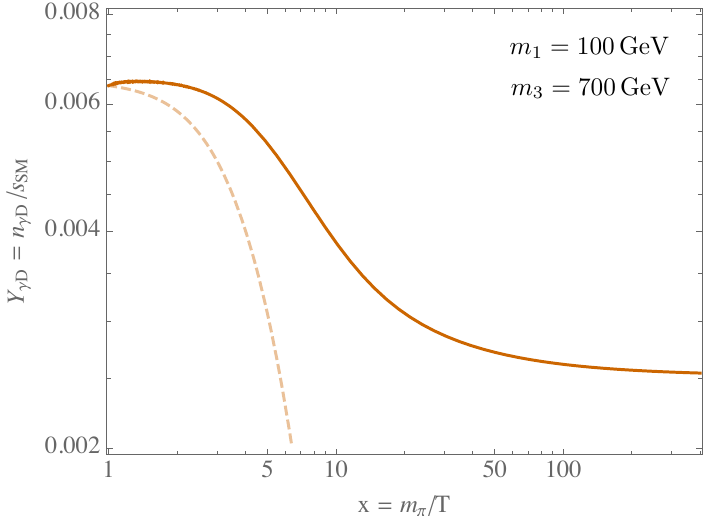
Figure 13 . Thermal evolution of the dark photon abundance obtained by solving numerically the system (C.1) with a = 1 / 2 and N DC = 4 . The solid orange line is the numerical solution for ε . 10 − 8 , while the dashed orange line corresponds to the thermal equilibrium density Y γ